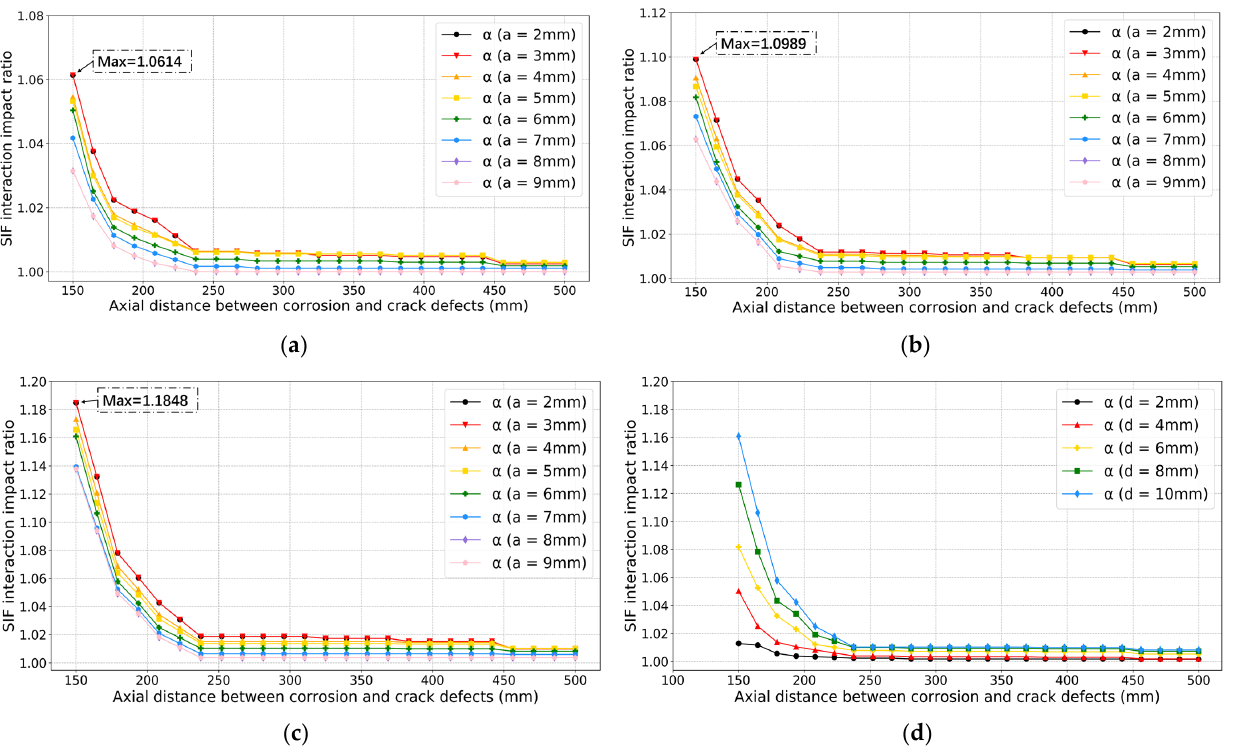
Figure 8. Prediction results of SIF interaction impact ratio based on approach 1. Corrosion depth d : ( a ) 4 mm; ( b ) 6 mm; ( c ) 10 mm; ( d ) Comparison results for different corrosion depths when crack depth a is 6 mm.